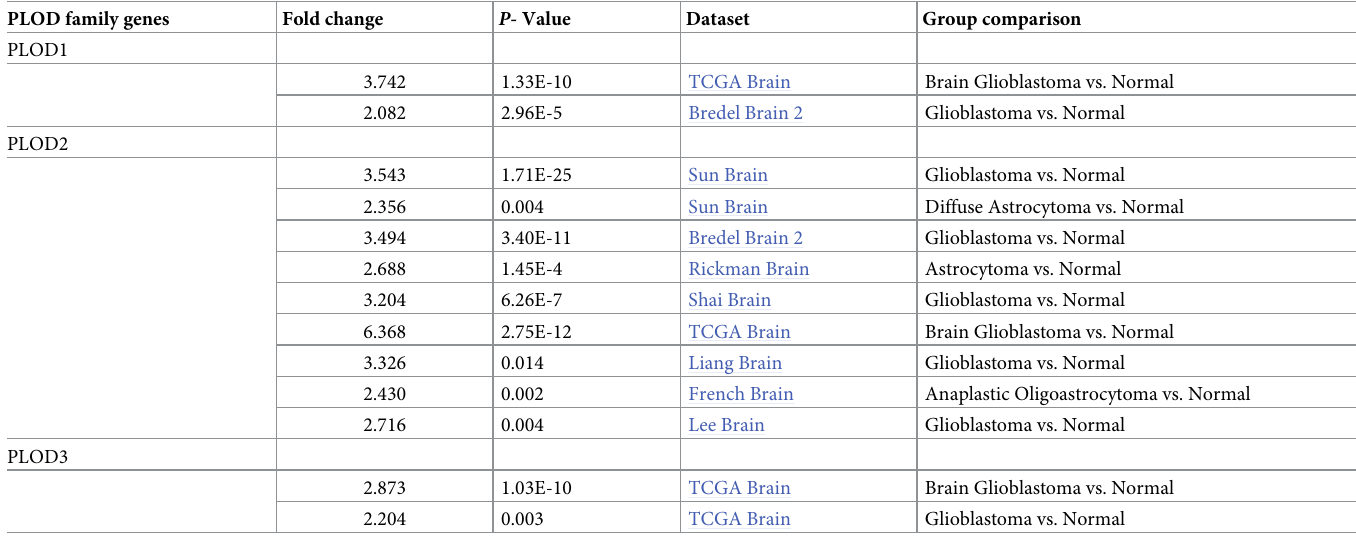
Glioblastoma vs.